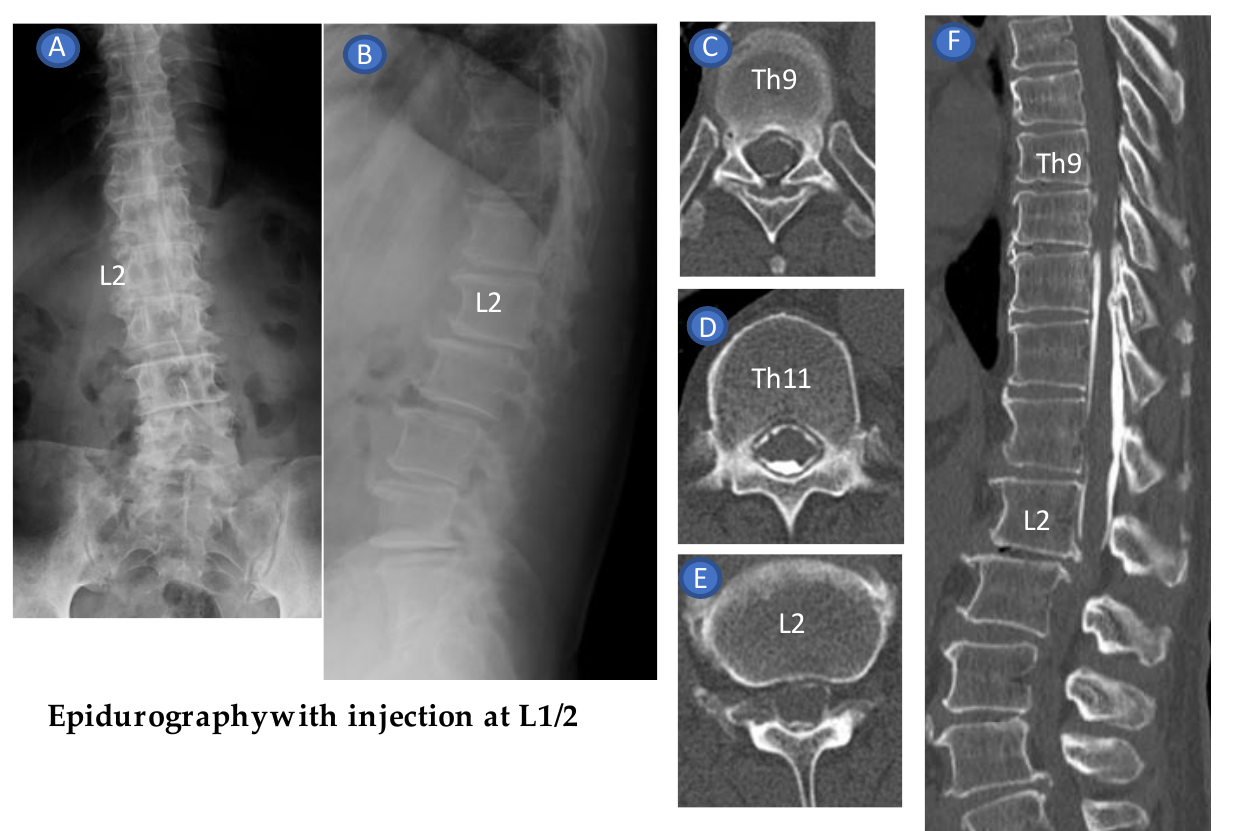
292 Figure 9. Paramedian sagittal oblique sonogram of the lumbar spine. Pulsatile SMI signal associated with inflammation. The ( left ) image shows no SMI signal at the L4/5 interlaminar spaces without disc herniation. The ( right ) image shows SMI signals indicated by a red line on the herniated disc. The SMI signals indicated by red arrows were detected as pulsatile flow in the epidural space be- tween the epidural fat layer and the anterior dura mater. Abbreviations: L. flavum, ligamentum flavum; L, lumbar; SMI, superb microvascular imaging. To confirm the accuracy of the ligamentum flavum rupture US-guided ILEDSI, we used a contrast medium instead of dexamethasone (5 mL iohexol-240 [Omnipaque-240; GE Healthcare Pharma, Tokyo, Japan]) in 5 mL of 0.25% lidocaine. After injecting the con- trast medium, the anterior-posterior and lateral epidurograms of the lumbar spine were captured (Figure 10A,B). The patients were subsequently placed supine within the gantry